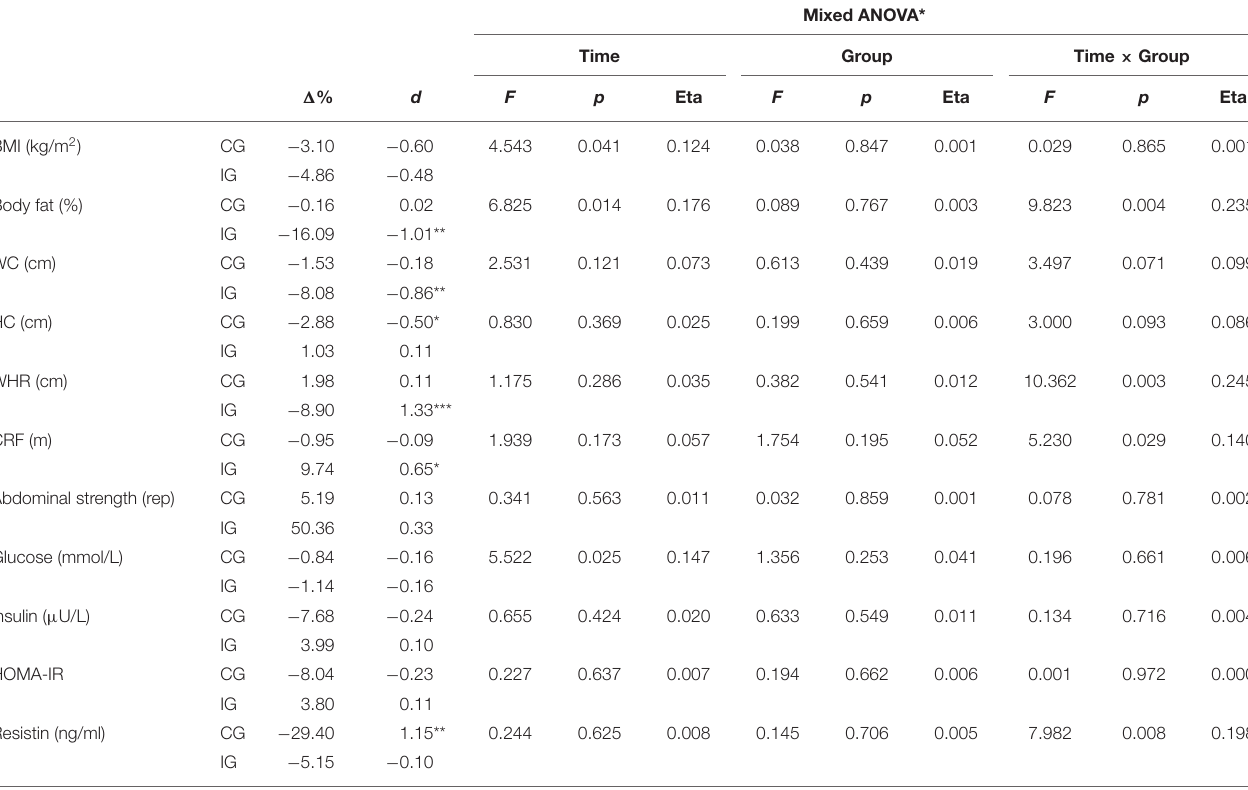
TABLE 2 | Effect of intervention on time, group, and interaction on indicators of body composition, aerobic and muscular physical fitness, insulin resistance, and serum resistin levels.